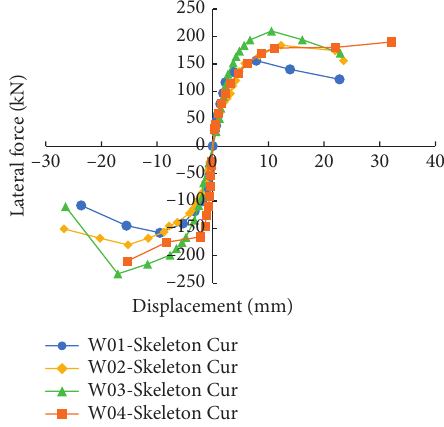
Figure 8: Skeleton curve comparison chart. Table 2: Displacement ductility of test